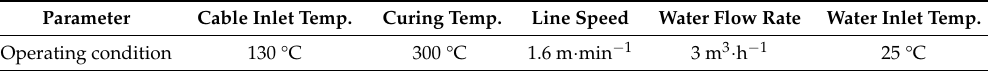
Table 2. CV line operating